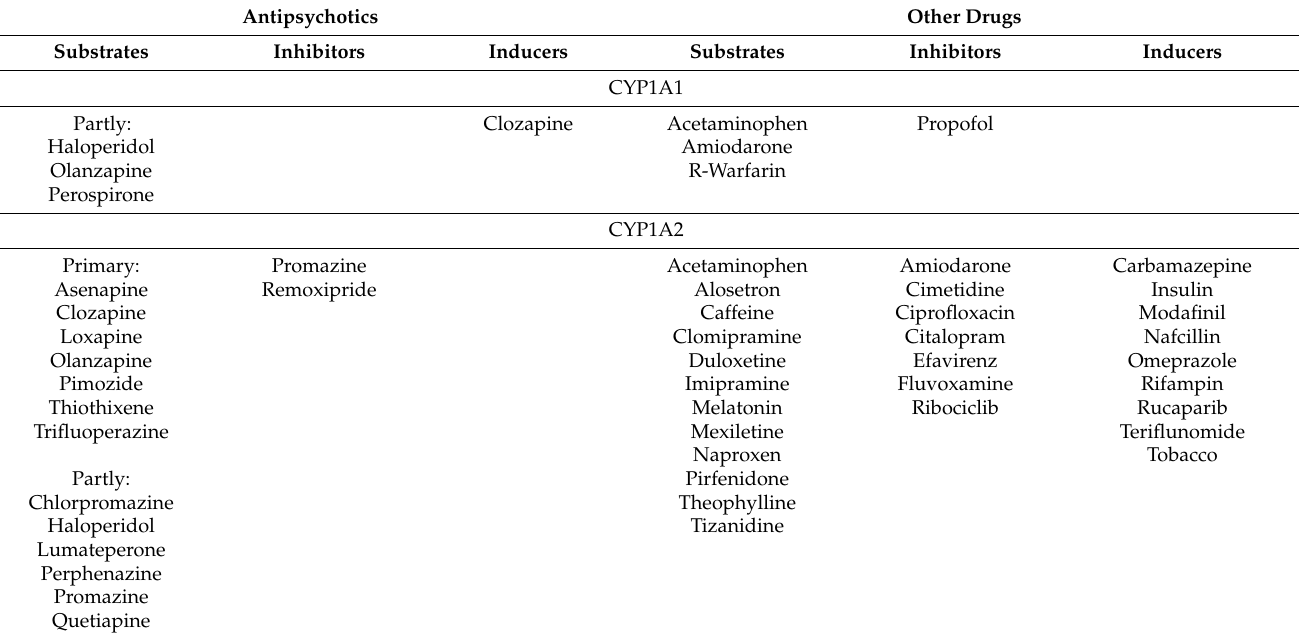
Table 1. Substrates, inducers, and inhibitors of cytochrome P450